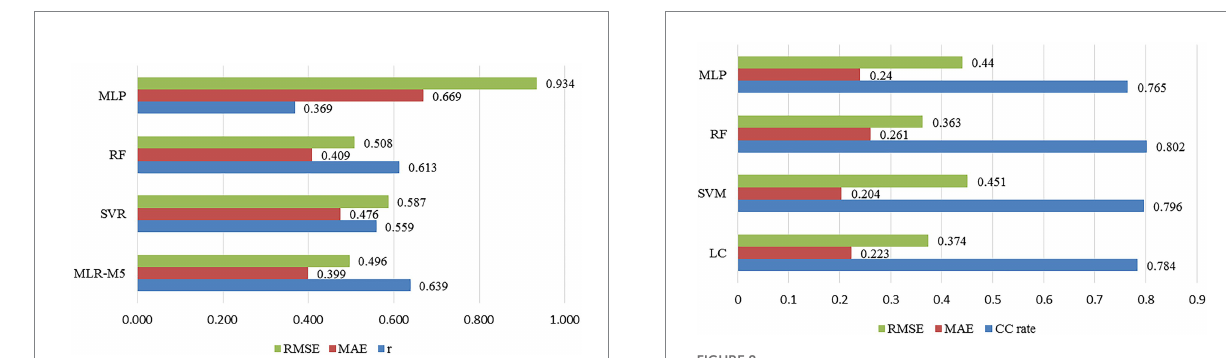
FIGURE 8 The comparison of the classification prediction results of the four machine learning algorithms.